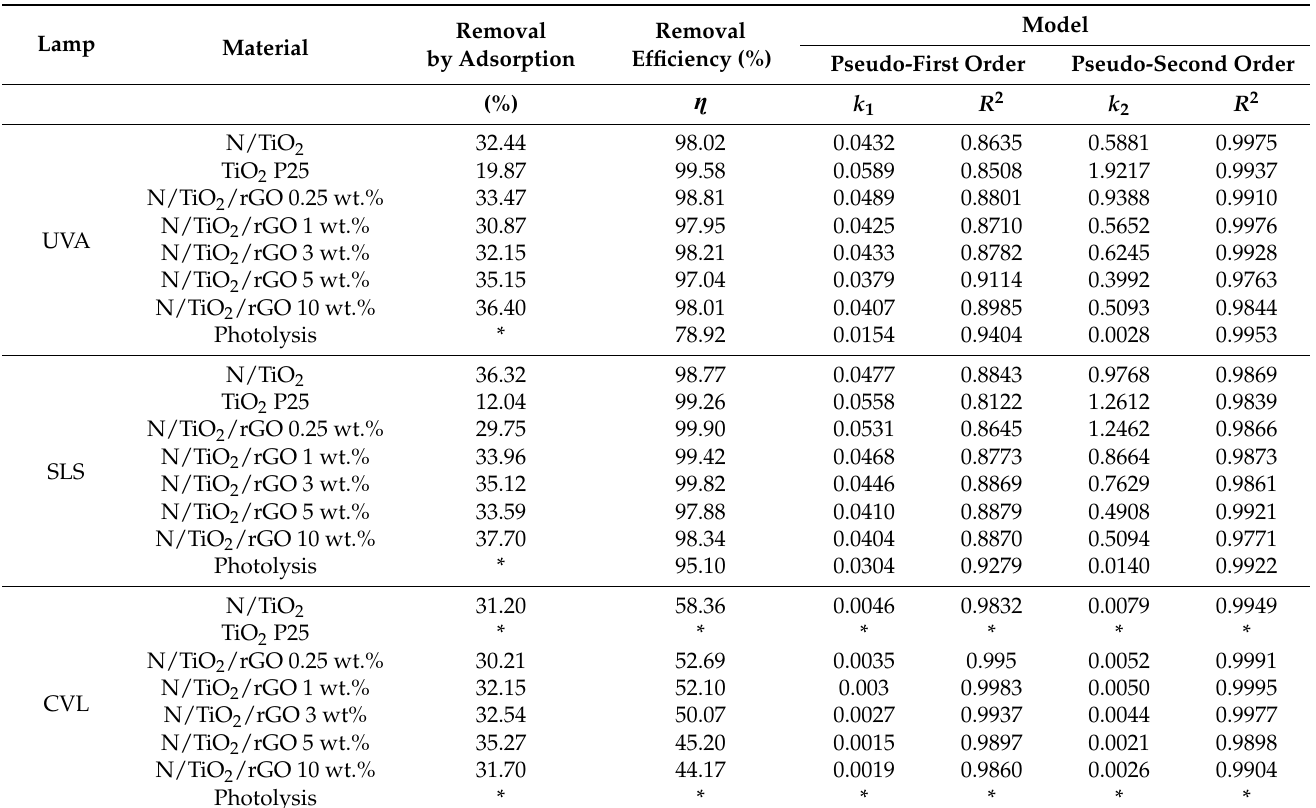
Table 4. Pseudo-first-order and pseudo-second-order kinetic parameters and efficiencies of CIP removal by N/TiO 2 , TiO 2 P25, and N/TiO 2 /rGO materials under UVA, solar light simulator (SLS), and cold visible light (CVL).